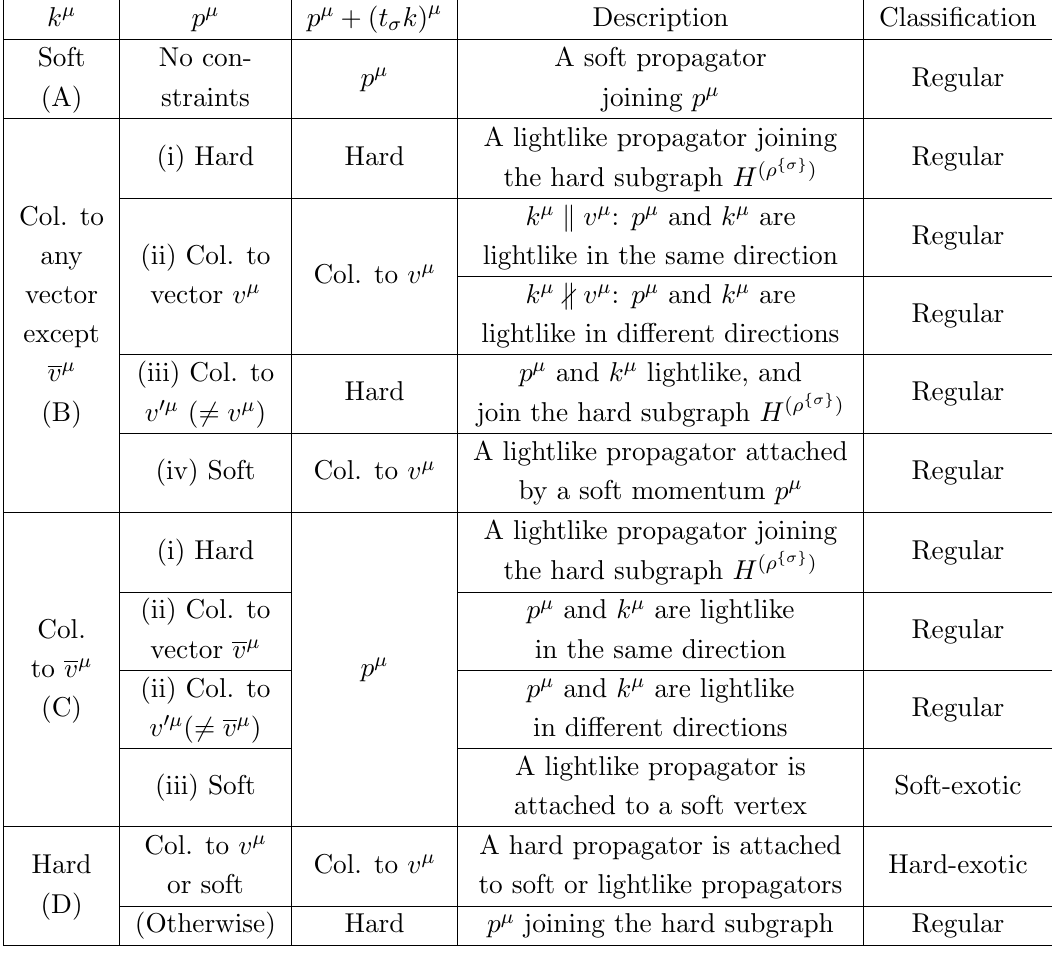
Table 1. Summary of the possible pinch con(cid:12)gurations of (cid:12)gure 4, which depend on p (cid:22) , k (cid:22) and p (cid:22) + ( t (cid:27) k ) (cid:22) = p (cid:22) + ( k (cid:1) v ) v (cid:22) in (cid:26) f (cid:27) g . The abbreviation \col." represents